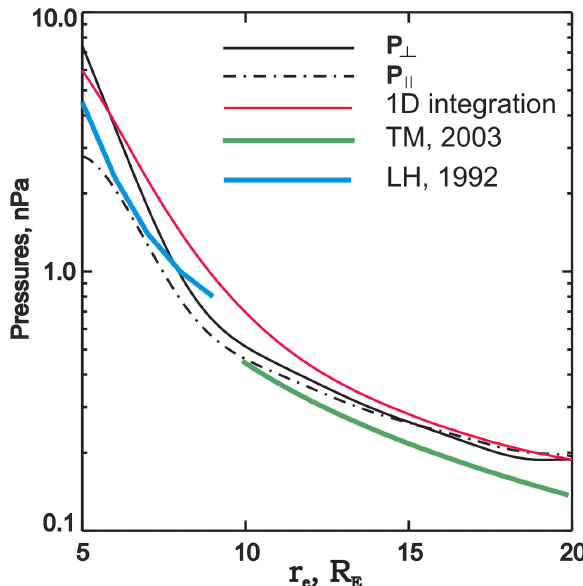
Fig. 17. Radial profiles of the equatorial perpendicular (black solid line) and parallel (dash-dotted line) pressures, obtained by minimizing the rms difference between the magnetic and plasma stresses in the T96 model (a quiet-time case). For comparison, isotropic pressure profiles by Lui and Hamilton (1992) (blue), Tsyganenko and Mukai (2003) (green), and that based on 1D integration of the same T96 field (red) are shown (from Tsyganenko, 2010).